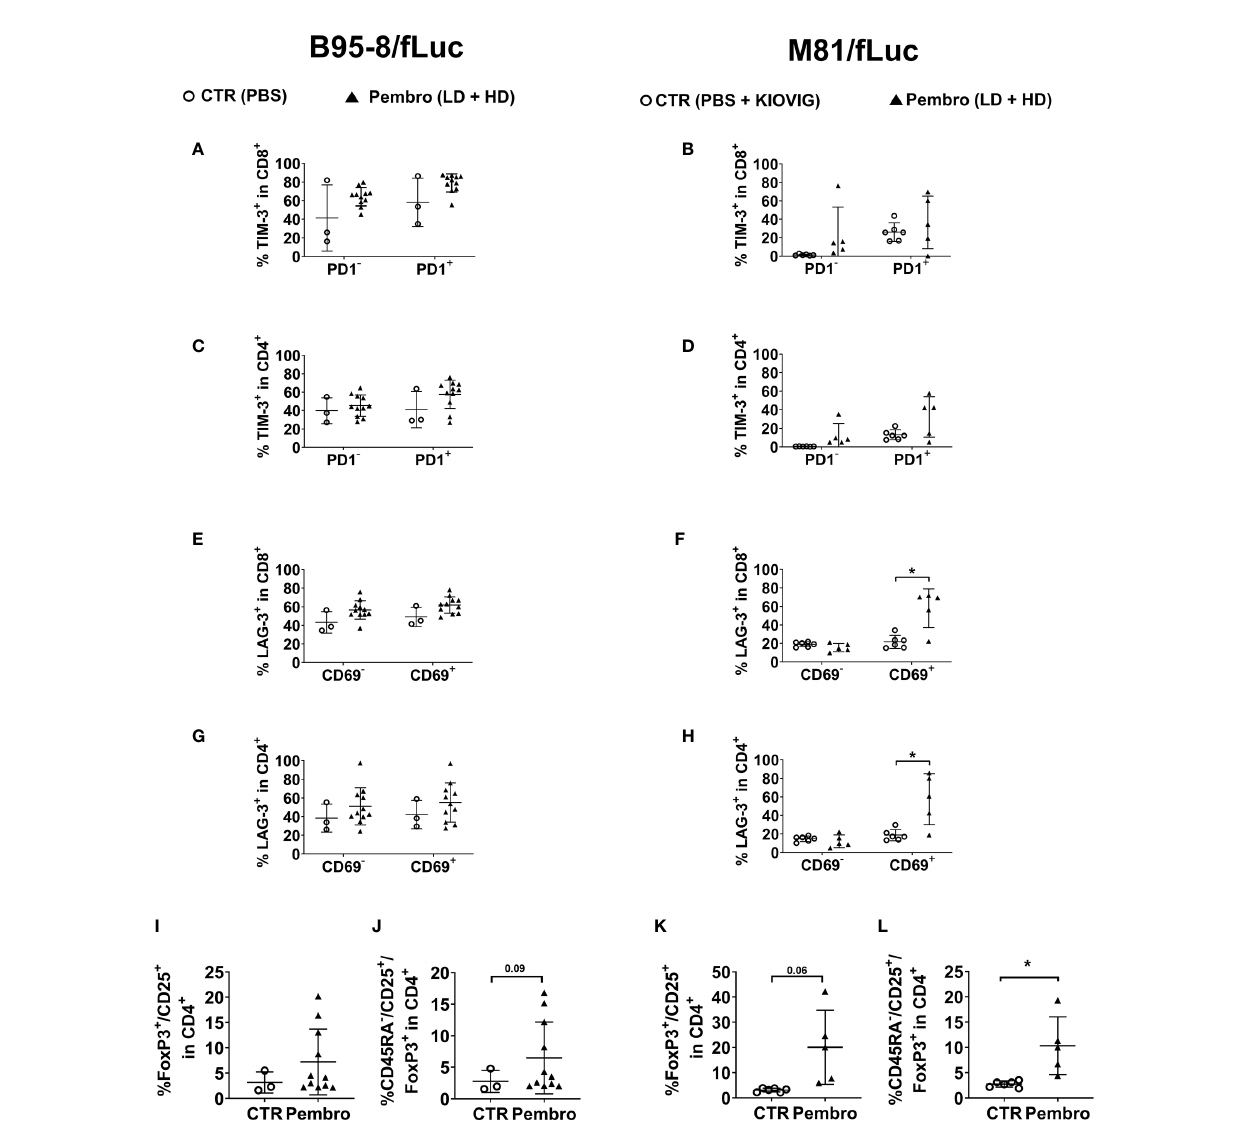
FIGURE 6 | The frequencies of T cells expressing TIM-3 or LAG-3 exhaustion markers or a regulatory T cell immunophenotype increased after pembrolizumab treatment. Frequencies of marker-positive lymphocytes recovered from spleen (SPL) comparing non-treated control mice (CTR, open circles) and pembrolizumab-treated cohorts are shown ( fi lled triangles; low-dose and high-dose treatments were merged for the analyses). Only mice surviving until the terminal analyses at 8 wpi were included in the terminal fl ow cytometry analyses. (A – D) Frequencies (%) of TIM-3 + in CD45 + /CD8 + (A, B) and of TIM-3 + in CD45 + /CD4 + (C, D) T cells are shown. PD-1 + (left side) or PD-1 − (right side) CD8 or CD4 subpopulations were analyzed separately. Higher proportion of TIM-3 + cells was observed more clearly for PD1 + T cells for both models. (E – H) Frequencies (%) of LAG-3 + in CD45 + /CD8 + (E, F) and LAG-3 + in CD45 + /CD4 + (G, H) T cells are shown. CD69 + (left side) or CD69 - (right side) CD8 or CD4 subpopulations were analyzed separately. Signi fi cantly higher proportion of LAG-3 + T cells were observed for activated CD69 + T cells for mice infected with M81/ EBV/fLuc and treated with pembrolizumab. (I – L) Frequencies (%) of CD25 + /FoxP3 + /CD45 + regulatory (I, K) and CD45RA - /CD25 + /FoxP3 + /CD45 + activated regulatory T cells (J, L) detected within the human CD4 + cells for B95-8 (I, J) and M81 model (K, L) . Pembrolizumab treatment was associated with higher proportion of regulatory T cells for both models. Unpaired Welch ’ s t test was used to compare treatment groups. *P < 0.05 . Standard deviation is